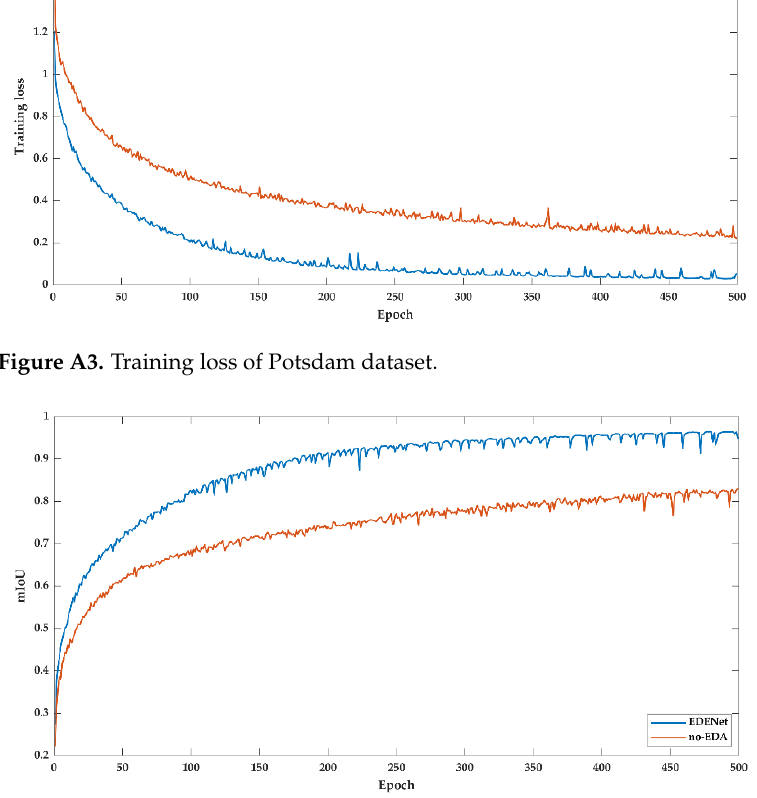
Figure A4. Training mIoU of Potsdam dataset.